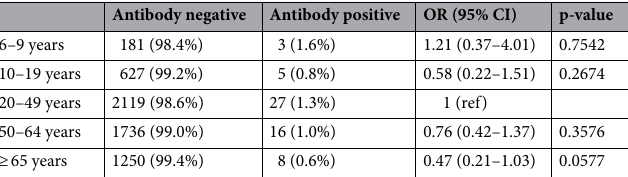
Table 3. The relative risk of SARS-CoV-2-specific seropositivity by age. OR odds ratio, CI confidence interval.